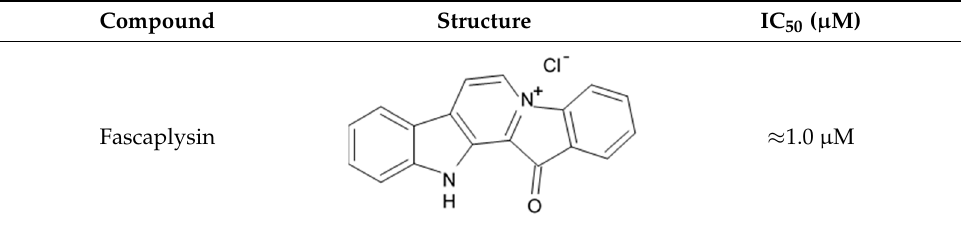
Table 3. Structure and cytotoxic activity of fascaplysin against glioma C6 cells [64].